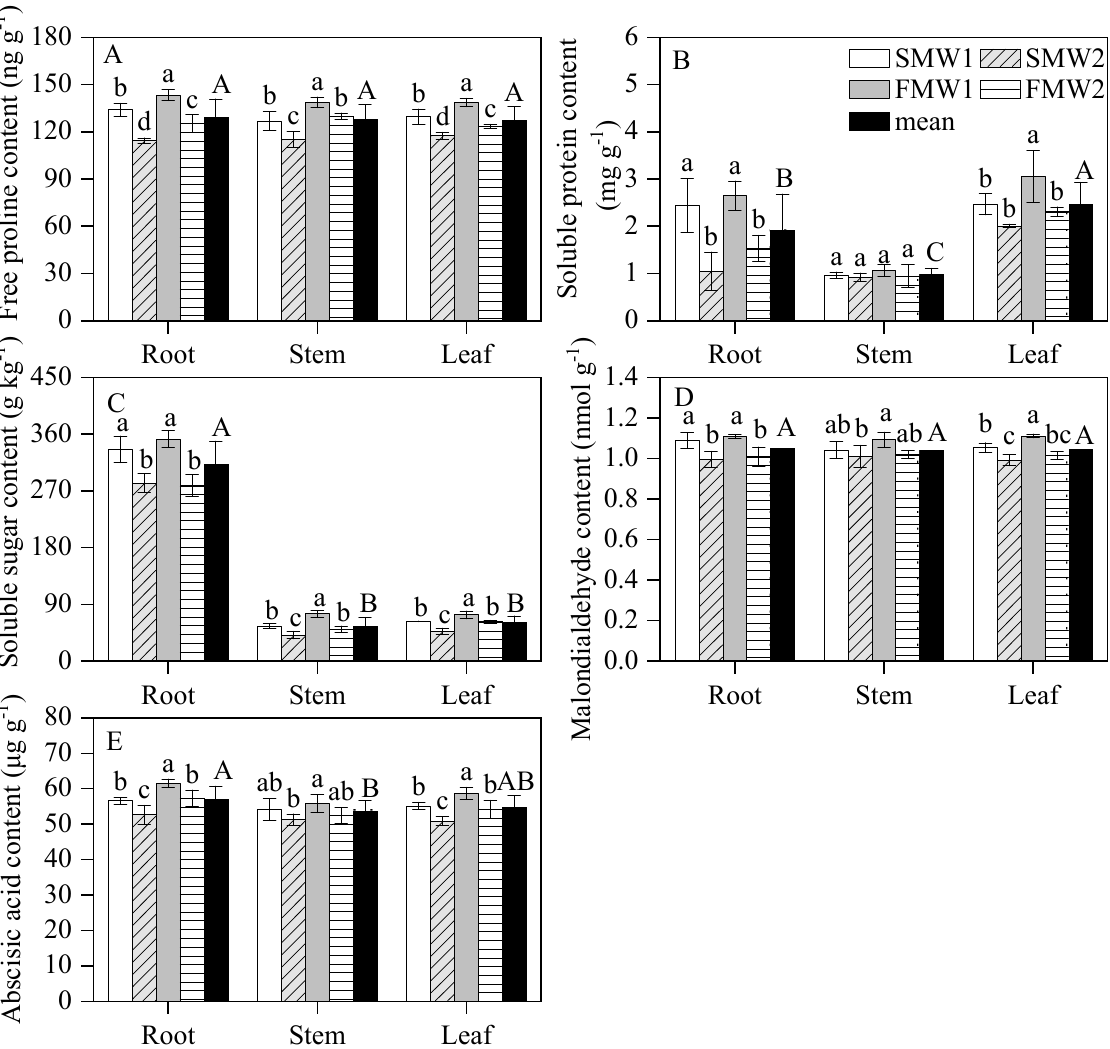
Figure 6. Effects of different treatments on osmotic substances ( A – C ), malondialdehyde ( D ), and abscisic acid (ABA) ( E ) contents in the tomato roots, stems, and leaves on the 21st day after treatment. Values are the mean ± SD (n = 3). Duncan’s multiple-range test was used to test for differences among treatments or organs at the p < 0.05 level. Different lowercase letters above the columns indicate significant differences among treatments within the same organ, and different capital letters on the mean value of all treatments in each organ indicate significant differences among organs.